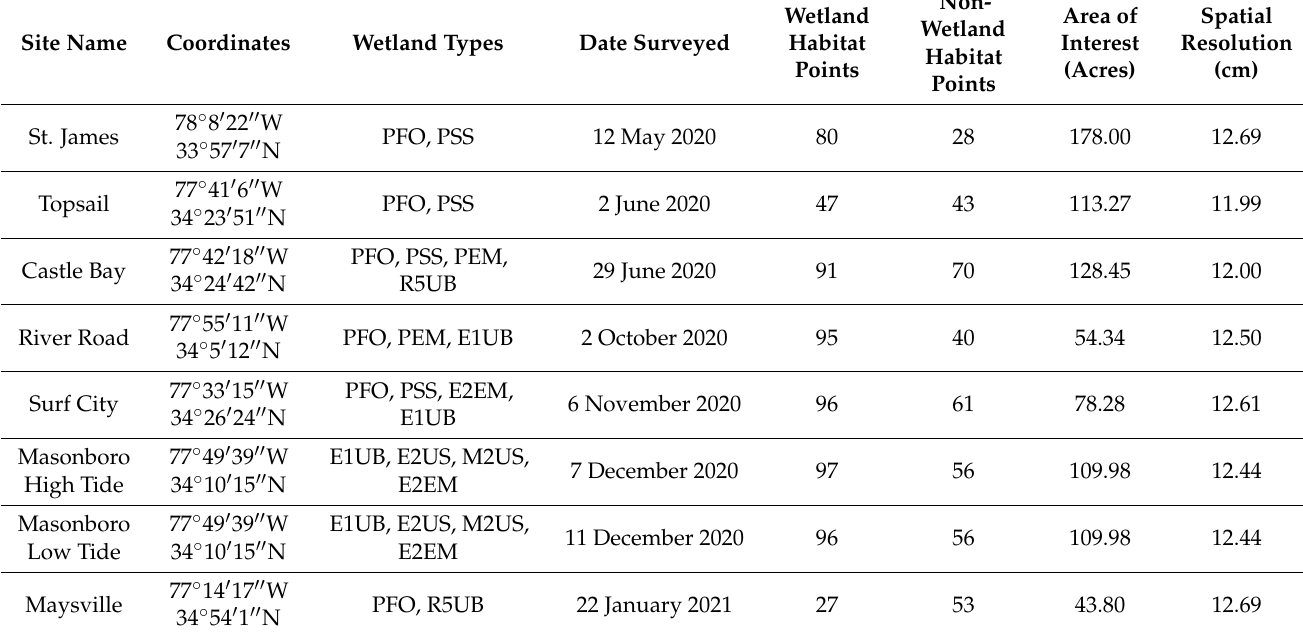
Table 1. List and Characteristics of Study